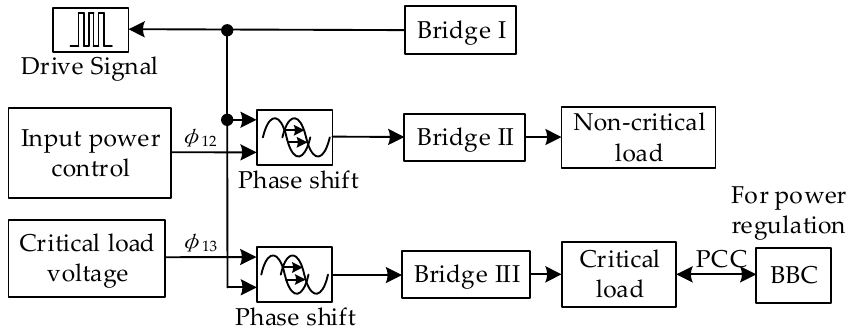
Figure 3. The proposed primary control of the DCES.